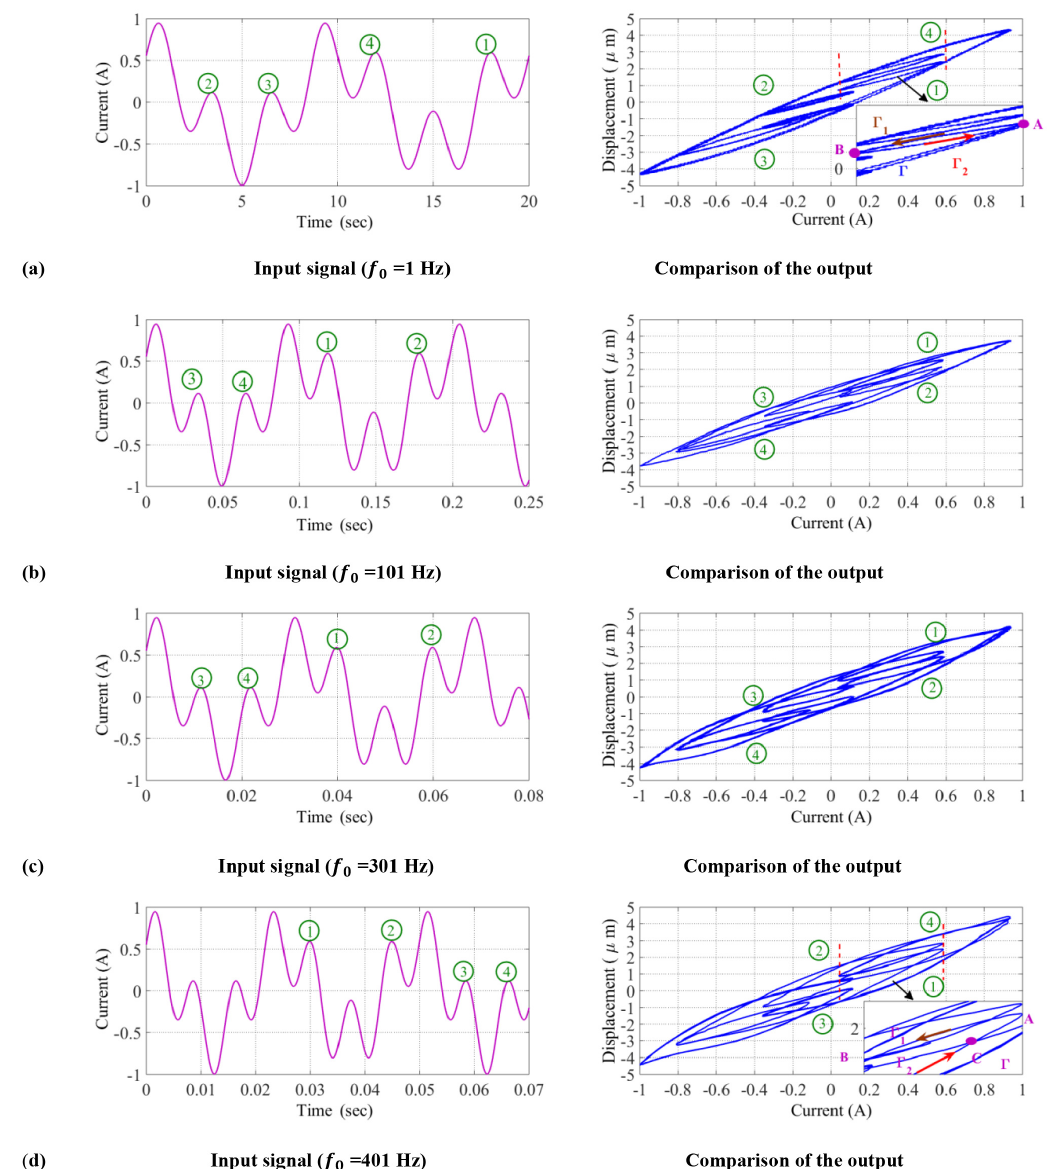
Figure 4. Minor loop hysteresis characteristics of the magnetostrictive actuated system at different fundamental frequencies: (a) f 0 = 1Hz; (b) f 0 = 101Hz; (c) f 0 = 301Hz; and (d) f 0 =